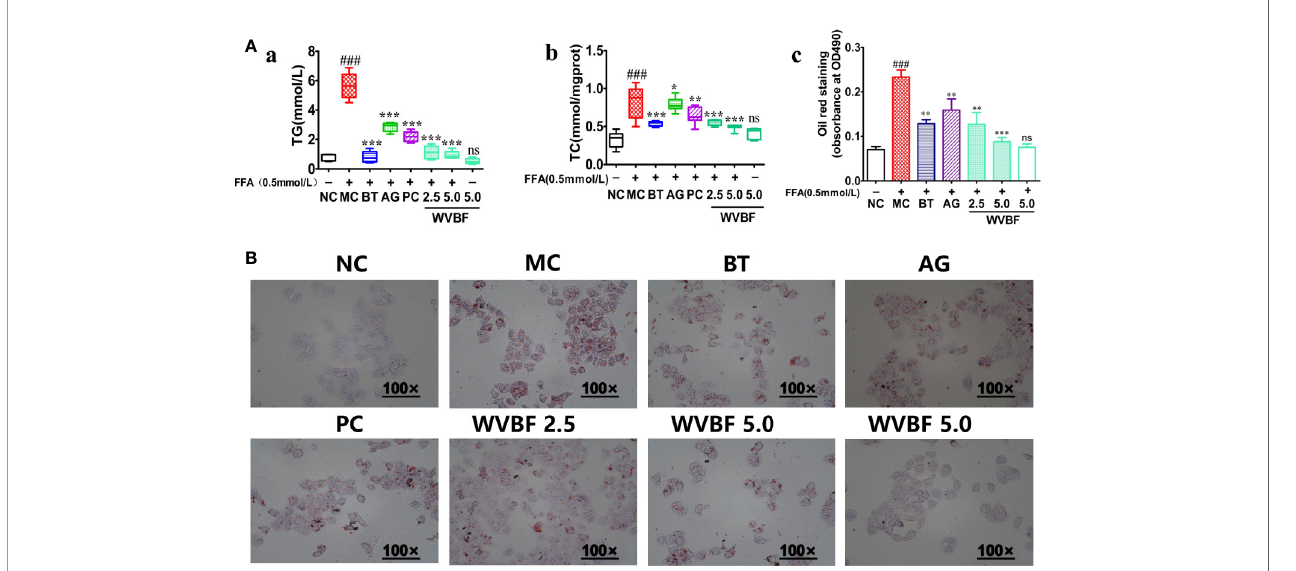
FIGURE 6 | Effect of water extract of Veratrilla baillonii (WVBF) on lipid metabolic factors and lipid accumulation in LO2 cells. (A) Effect of WVBF on TG (a), TC (b), and quantitative results of graph-B detected by spectrophotometer at OD490nm (c) in LO2 cells. (B) Effect of WVBF on lipid accumulation in LO2 cells subjected to free fatty acids (FFA) (the deeper the red oil stain, the more lipid accumulation in the cell). ( ## P < 0.01, ### P < 0.001 vs . control groups; * P < 0.05, ** P < 0.01, and *** P < 0.001 vs . FFA